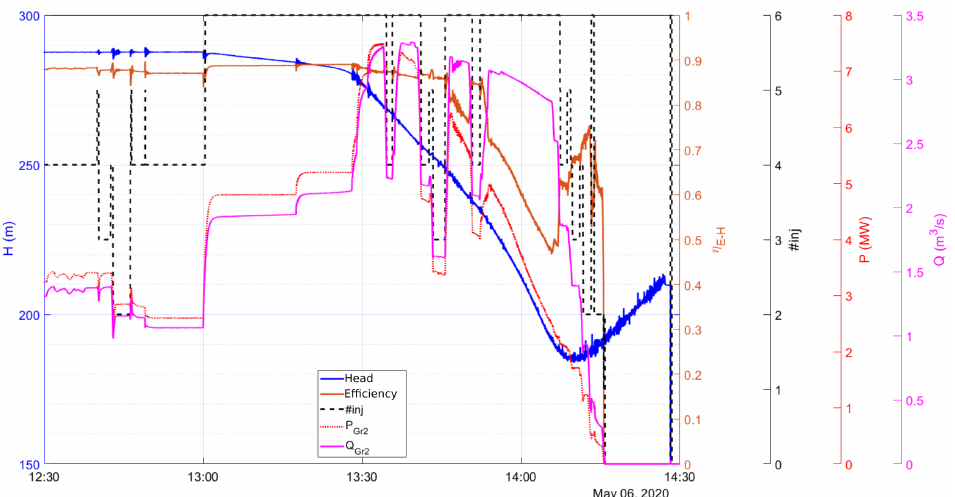
Figure 14. Time history of the head, the power, the efficiency, the flow discharge, and the number of opened injectors for group 2 during the third